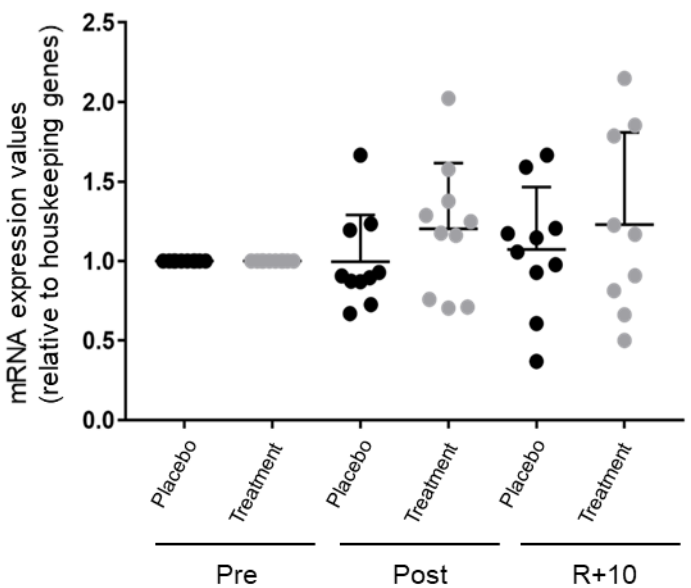
Figure 7. Nuclear factor erythroid 2-related factor 2 (Nrf-2) quantitative PCR analysis in VL muscle biopsies. Scatter plots showing the relative mRNA expression levels of Nrf-2 in VL muscle biopsies before (Pre) and after (Post) BR and 10 days after ambulation or recovery (R + 10). Nfr-2 mRNA levels of each subject enrolled in the two BR campaigns ( n = 10 for each campaign) are shown (Significant difference, ANOVA and t -test, n = 10, p -value ≤ 0.05). The graph represents the mean ± SEM.